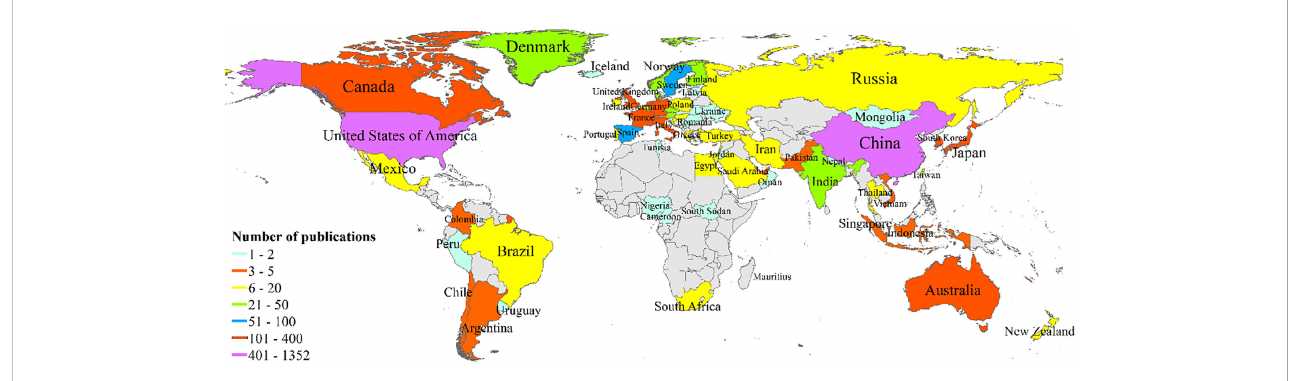
FIGURE 3 Distribution of publications by country and region based on